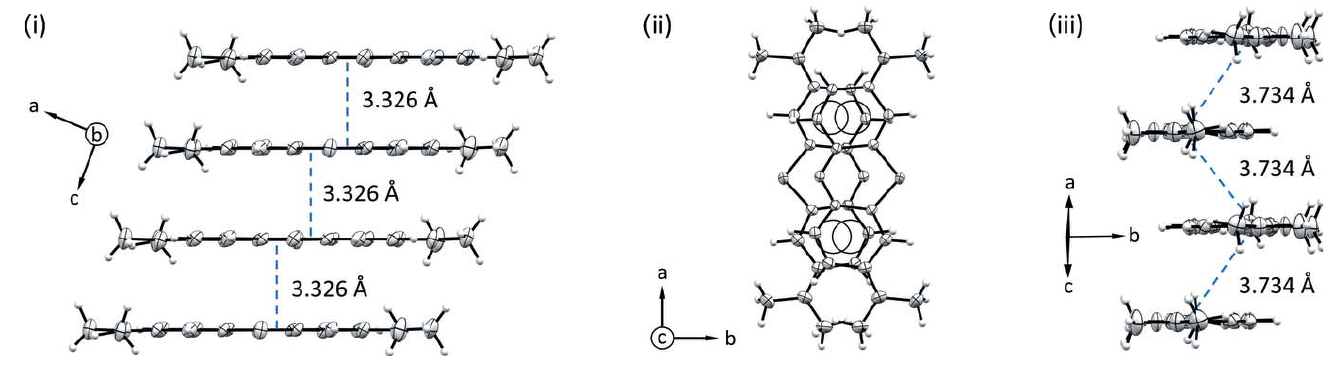
Figure 5 Views of the stacking geometry of MB + in compound ( I ): (i) displayed orthogonally to the stacking pillar axis by showing a tetramer of stacked molecules; (ii) the same group of MB + cations is shown along the stacking direction; (iii) view along the MB + longer dimension, highlighting the mutual shifts of the cations in the zigzag columns.